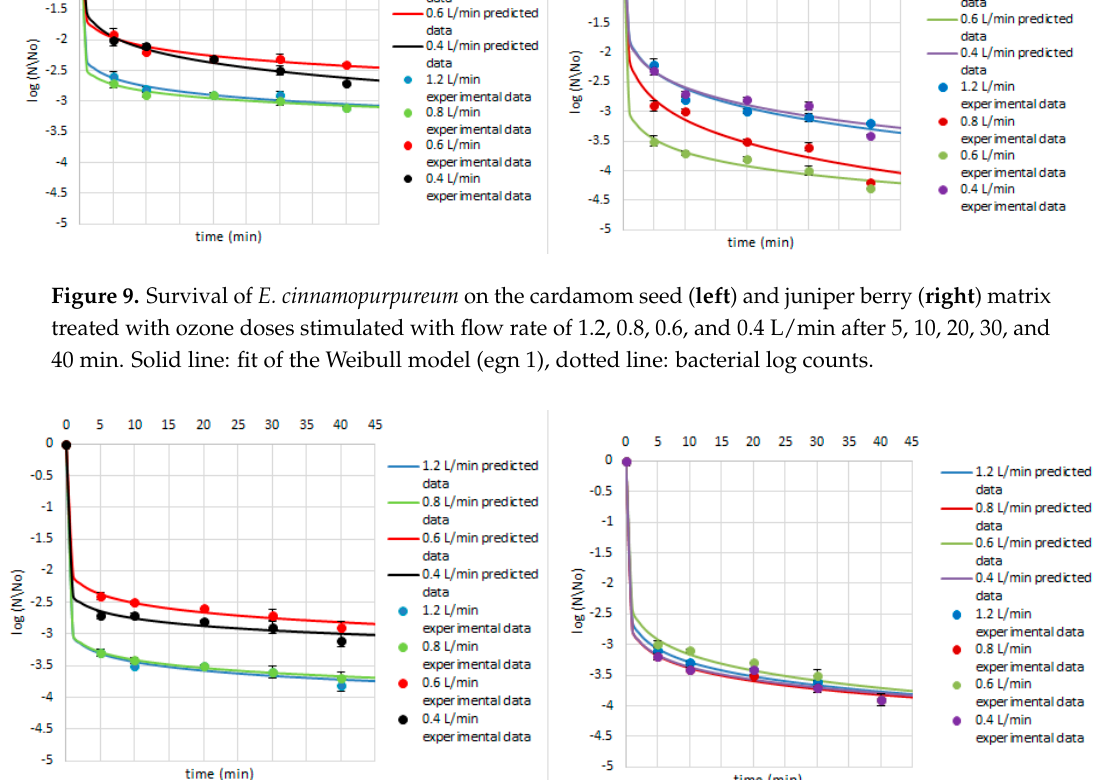
Figure 10. Survival of A. niger on the cardamom seed ( left ) and juniper berry ( right ) matrix treated with ozone doses stimulated with flow rate of 1.2, 0.8, 0.6, and 0.4 L/min after 5, 10, 20, 30, and 40 min. Solid line: fit of the Weibull model (egn 1), dotted line: bacterial log counts.